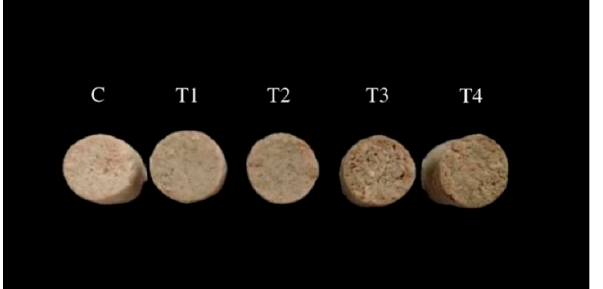
Figure 2. Transverse sections of cooked lower-fat pork batters prepared with various amounts of ORP; C: meat batter without ORP; T1: meat batter containing 1% ORP; T2: meat batter containing 2% ORP; T3: meat batter containing 3% ORP; T4: meat batter containing 4% ORP.